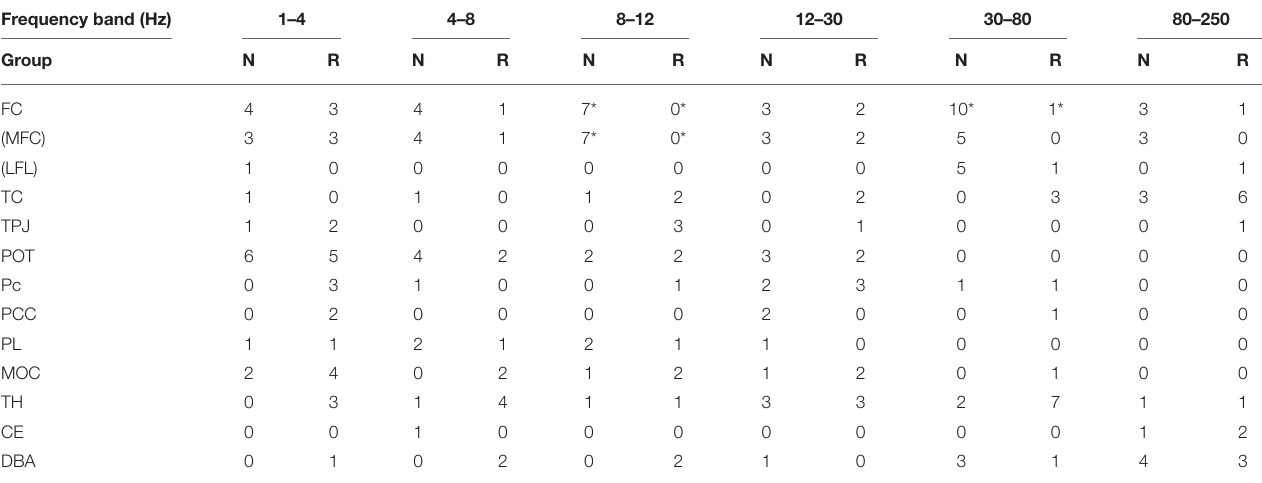
TABLE 2 | Magnetic location in the brain of the responders and nonresponders.